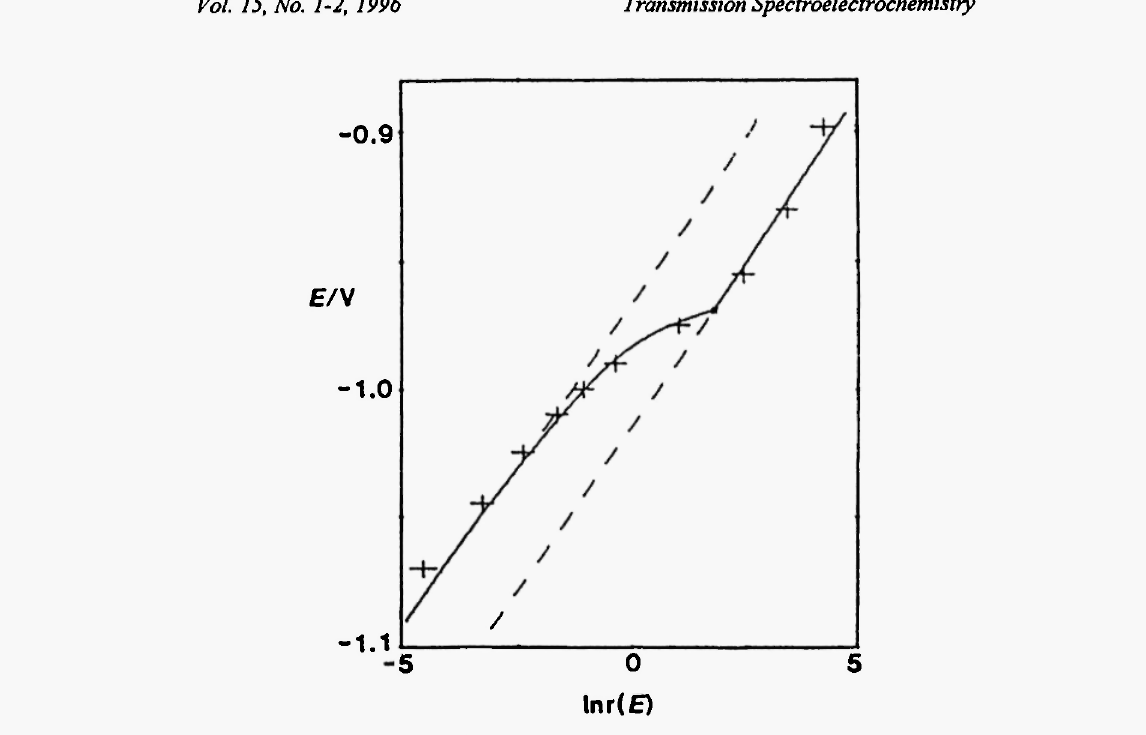
Fig. 28: Ε as function of ln[r(£)]. Experimental points measured at λ = 368 nm are denoted by +. The solid curve is Eqs.(77) and (80) with £° = -1.014 V, s R = 0.35 mM and C° = 2.36 mM. The dashed curves are the asymptotes Eqs. (78) and (81). (From Ref.